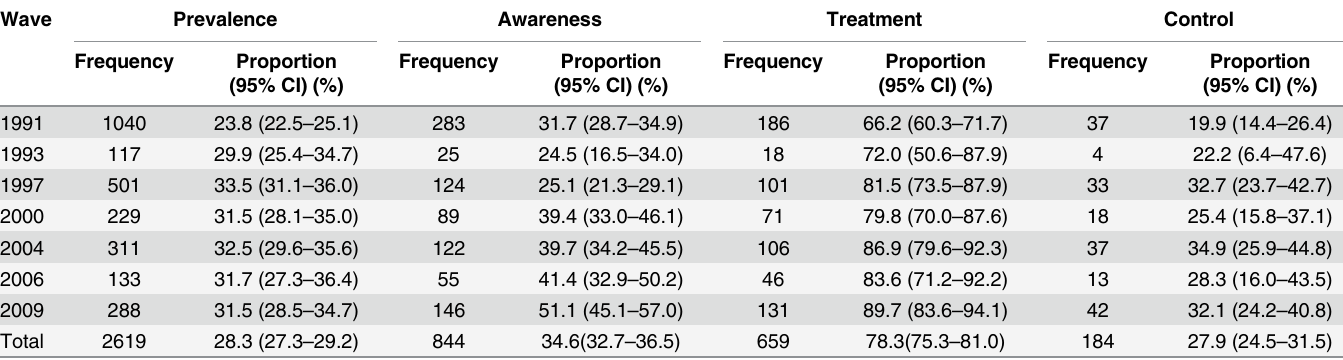
Table 3. Prevalence, awareness, treatment and control of hypertension.